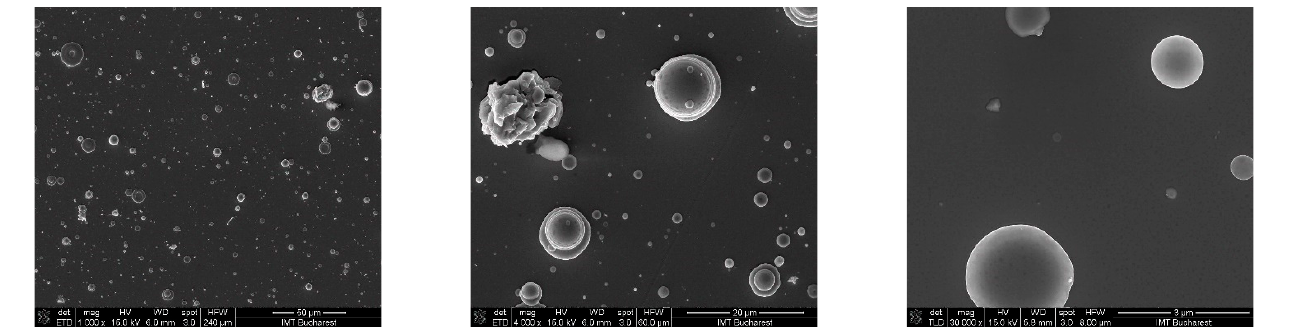
Figure 3. Typical SEM images of the surface morphology of a HEA6 thin film at different magnifi- cations: 1000×, 4000×, and 30,000×, from left to right, respectively.